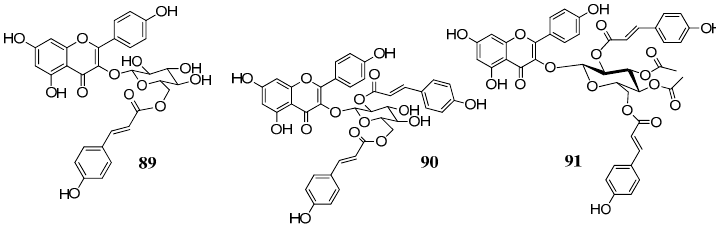
Figure 19. Structures of tested acylated flavonol glycosides 89 – 91 (isolated from Quercus ilex ) [71].